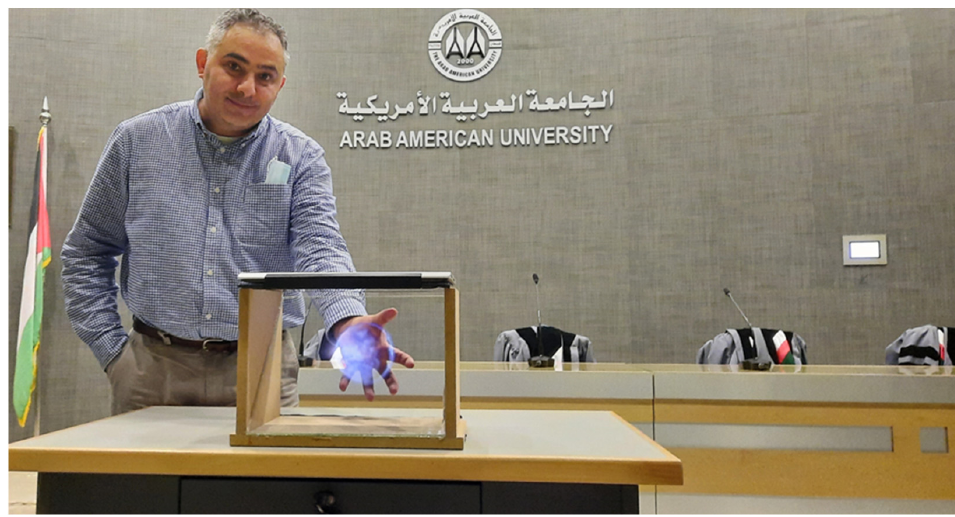
Figure 4. Demonstration of hologram experiment showing the earth.